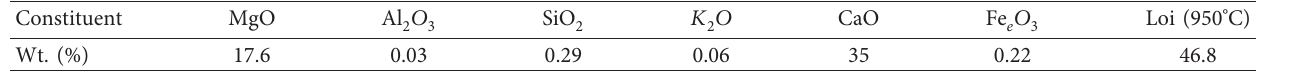
Table 1: Chemical composition of